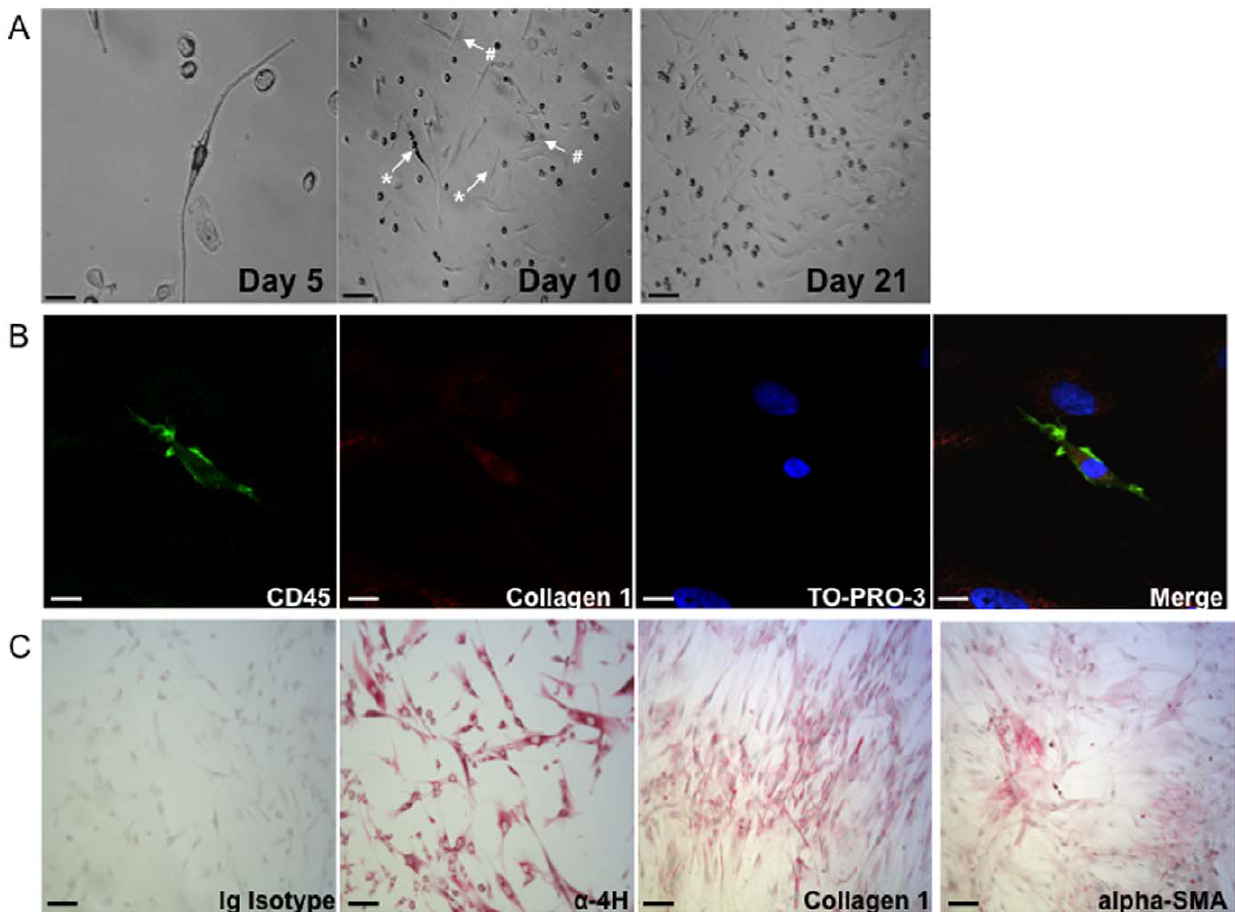
Figure 5. Characterization of bronchoalveolar lavage cells in culture. A ) Morphology of adherent bronchoalveolar lavage (BAL) cells at amplification when a positive culture occurred. From left to right: after 5 days (scale bar = 25 m m), at 10 days (scale bar = 250 m m) and at 21 days (scale bar = 250 m m). The arrows indicate typical adherent mesenchymal cells with high (*, fibrocyte phenotype) or low ratio ( # , fibroblast phenotype) of cell length to cell width. B ) Confocal microscopy analysis of fibrocytes (spindle-shaped cells co-expressing CD45 and collagen) in BAL cell culture at day 21. From left to right: CD45, collagen 1, thiazole orange protein 3 (TO-PRO-3) and merge of the three fluorescence channels. Scale bars = 15 m m. C ) Representative immunocytochemical stain prepared from alveolar fibroblasts at passage 1. From left to right: Ig Isotype, a -propyl-4- hydroxylase ( a -4H), collagen 1, a -smooth muscle actin (a-SMA). Scale bars = 100 m m.